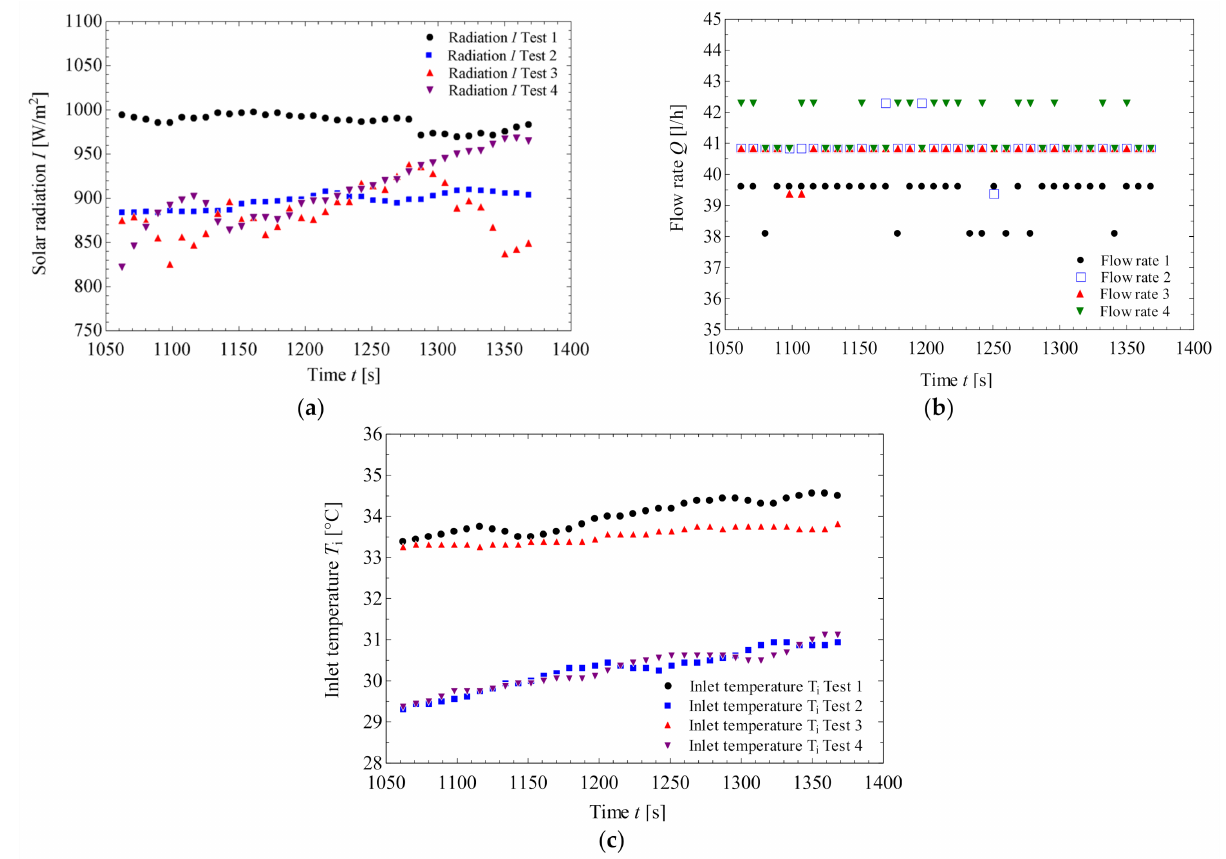
Figure 12. Steady state of ( a ) solar radiation, ( b ) flow rate, ( c ) temperatures.